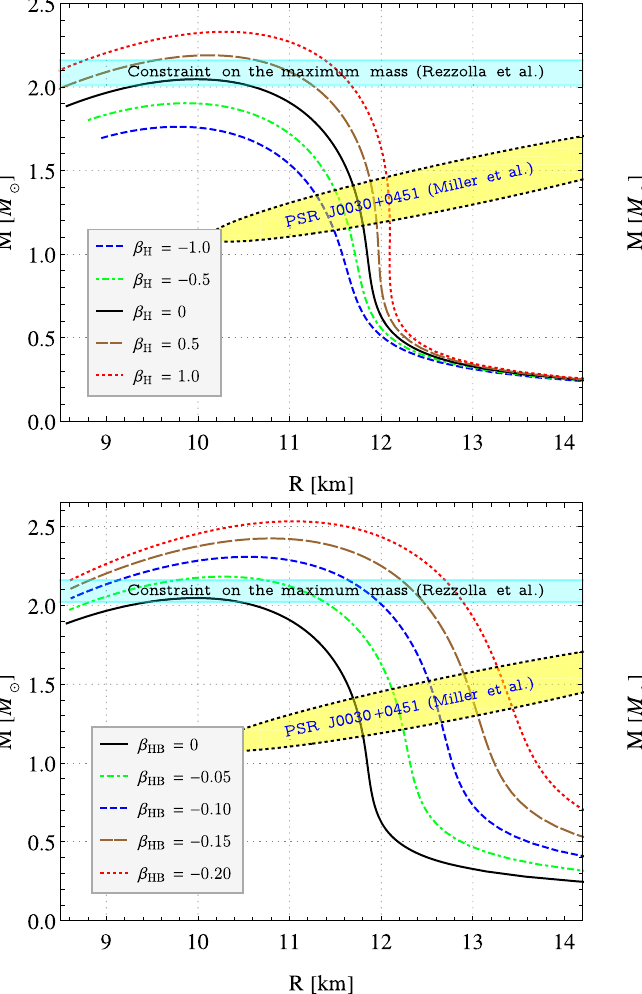
of both mass and radius measurements for PSR J0030 + 0451 from NICER data [99]. The horizontal narrow band in cyan color stands for the recent restriction of maximum mass of neutron stars as a result of observation of the GW event GW170817